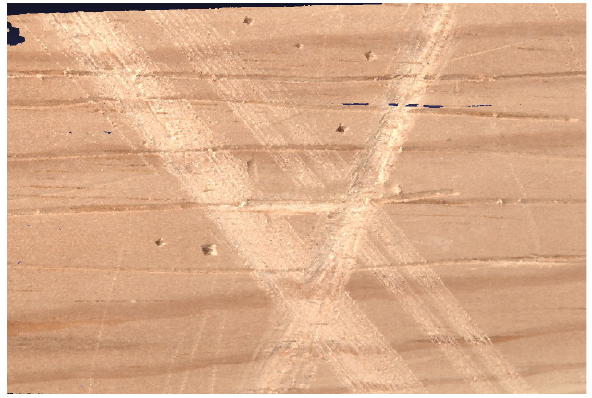
Figure.9.  3D model